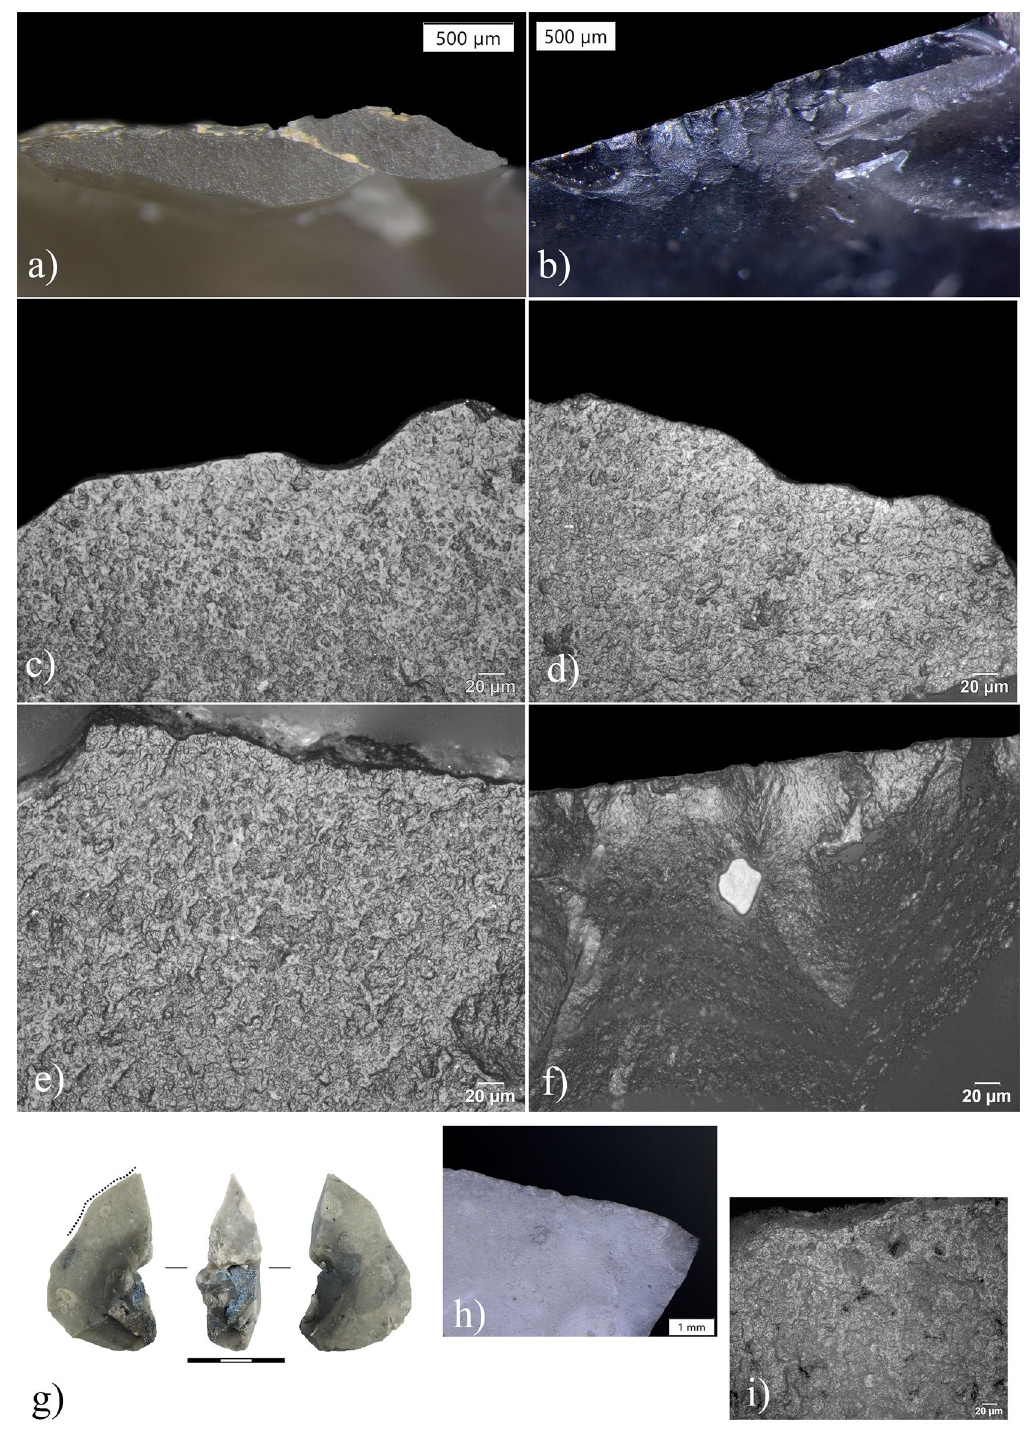
Figure 3. Archeological macro and microscopic use-wear traces on lithic artifacts from the elephant area at Schöningen 13 II-3. ( a ) view of the butt of the resharpening flake ID 28802 with a well-developed rounding along the external platform edge and yellow-orangish use-related microresidues (Magnification: 56x); ( b ) micro- edge damage developed along the dorsal face of the resharpening flake ID 29711 (Magnification: 56x); ( c–e ) micro-polish recorded on the butt of three resharpening flakes (ID 30876, 30878, 29716, Magnification: 500x) and interpreted as evidence of working fresh wood; ( f ) micro-polish recorded on the dorsal outer edge of the resharpening flake ID 29711 (Magnification: 500x); ( g ) natural flint fragment ID 29967; ( h ) edge damage along the natural sharp edge (Magnification: 25x); ( i ) micro-polish interpreted as related to the processing of fresh animal tissues, including hide (Magnification: